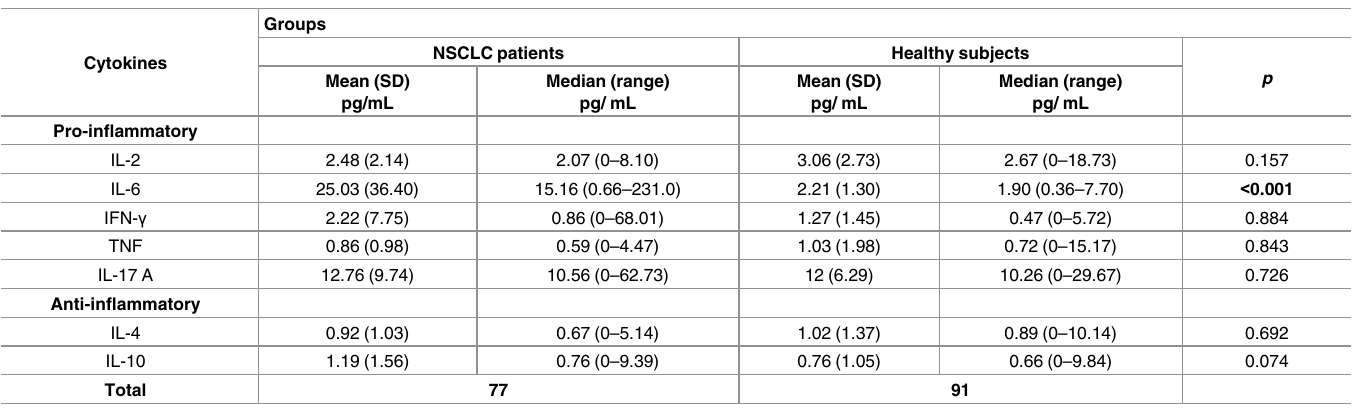
Table 2. Cytokine expressionlevels between NSCLC patients and healthy